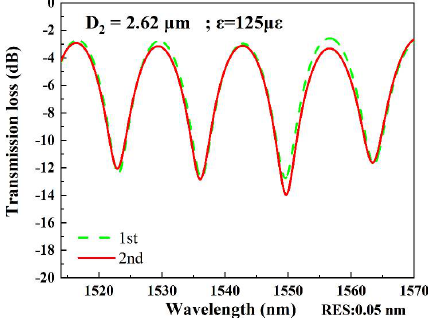
122–213.5 με at 1513–1570 nm. ( b ) Linear fitting curves of the dip wavelength shifts and the coefficients of determination R 2 of linear fitting with D 2 = 2.62 μm.